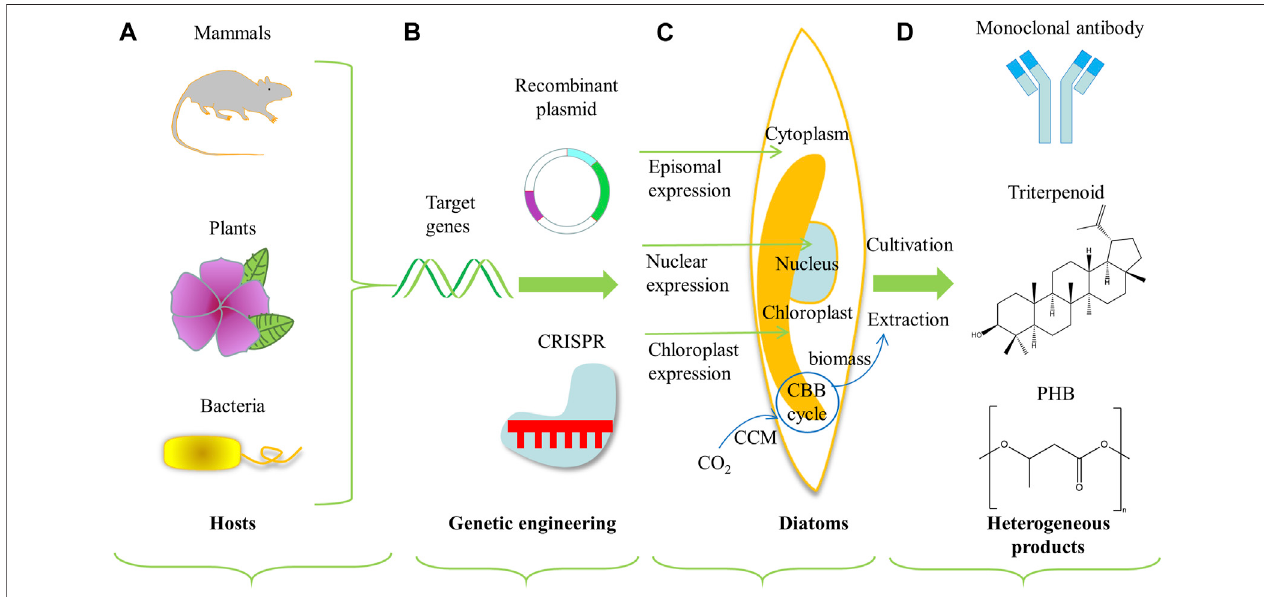
FIGURE3| Schematicdiagramofengineeringdiatomsascellfactoriesforheterologousproductionofvalue-addedcompounds.Heterologousexpressionsystem includes (A) the selection of target source genes, (B) conventional genetic engineering or genome engineering technologies like CRISPR, (C) DNA transformation and expression locus in diatoms, and (D) production of value-added compounds (D ’ Adamo et al., 2019). The part with blue cycle and arrows represents the framework for inorganic carbon utilization. Abbreviations: CBB, Calvin – Benson – Bassham cycle; CCM, carbon concentrating mechanism; PHB, Poly- β -hydroxybutyrate.